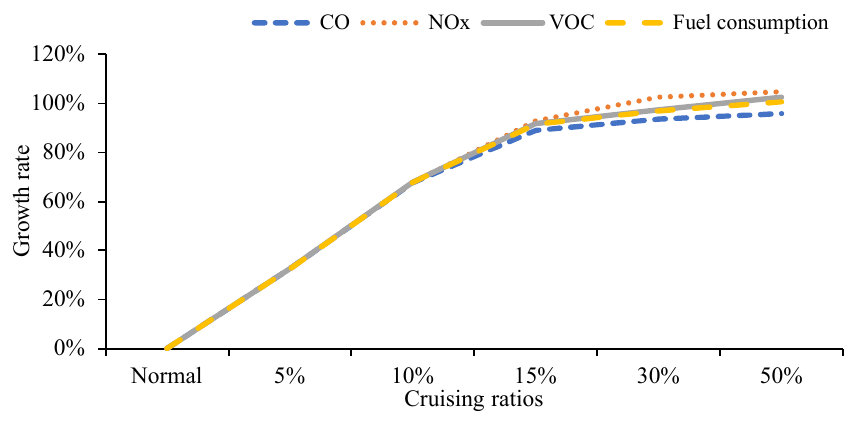
Figure 23. Growth rate of road network emissions.